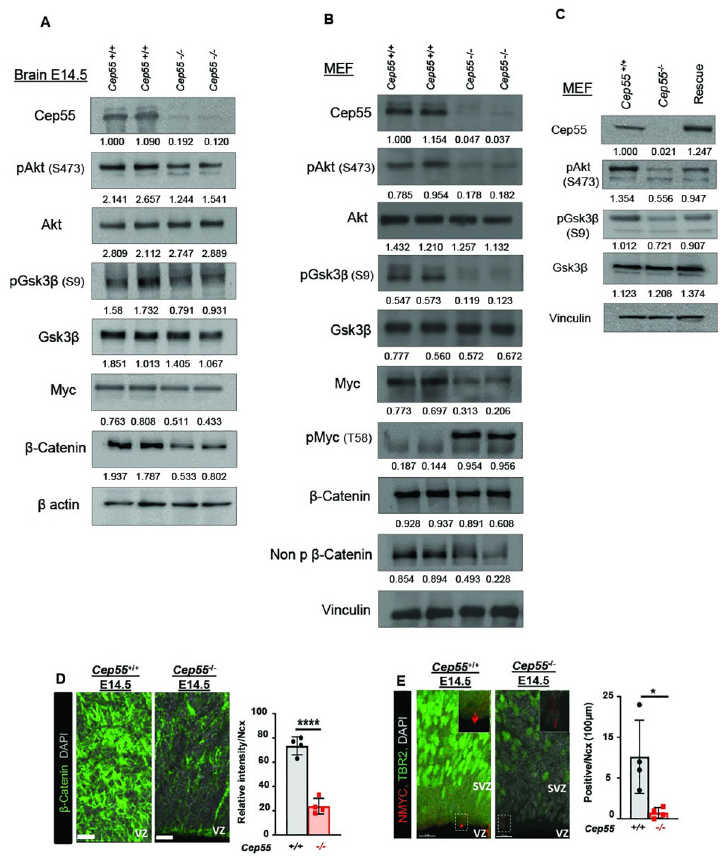
Fig 5. Cep55 regulates GSK3 β , β -Catenin and Myc downstream of the Akt pathway. (A-C) Representative image of immunoblot (WB) analysis with indicated antibodies. Numbers at the bottom of each WB lane represent the relative quantification of band intensities normalized to the signal of each loading control. β actin or vinculin served as a loading control. Immunoblot performed to compare (A) Cep55 +/+ and Cep55 -/- mouse embryonic brain at E14.5. (B) Cep55 +/+ and Cep55 -/- MEFs. (C) Cep55 +/+ (Wt), Cep55 -/- (KO) and Cep55 -/- MEFs with ectopic expression of CEP55 (Rescue) with indicated antibodies. (D) Representative images of Cep55 +/+ (left) and Cep55- /- (right) neocortices stained for β -catenin and nuclei (DAPI) in a 100 μ m-width box. Bar chart shows the relative intensity of β -catenin signals for Cep55 +/+ and Cep55 -/- neocortices, p < 0.0001; Scale = 50 μ m. (E) Representative images of Cep55 +/+ (left) and Cep55 -/- (right) neocortices stained for N-Myc (red), Tbr2 positive cells and nuclei (DAPI) in a 100 μ m-width box. Bar chart shows the percent of N-Myc positive cells, p < 0.0232, scale = 15 μ m (Mean ± SD of four embryos duplicate technical repeats, Student’s t-test, � p < 0.05, �� p < 0.01, ��� p < 0.001, ���� p <